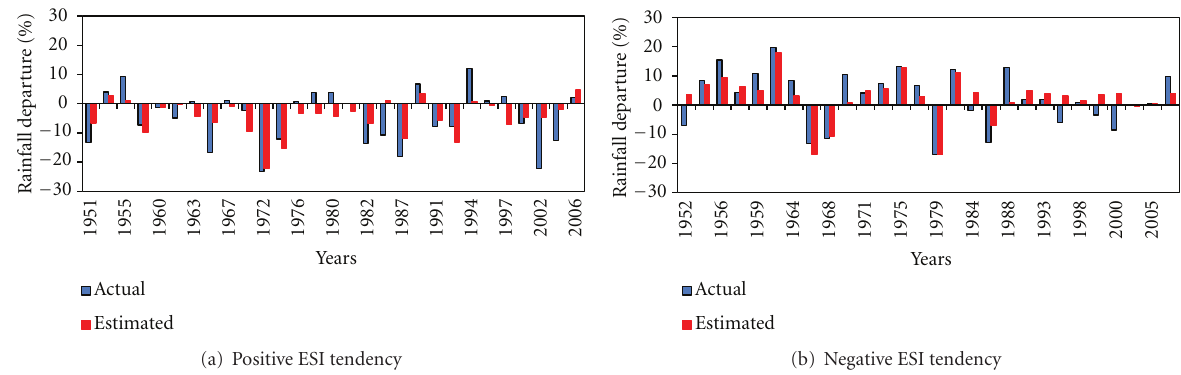
Figure 6: Actual and estimated % rainfall departure of all India during (a) positive and (b) negative phase of ESI